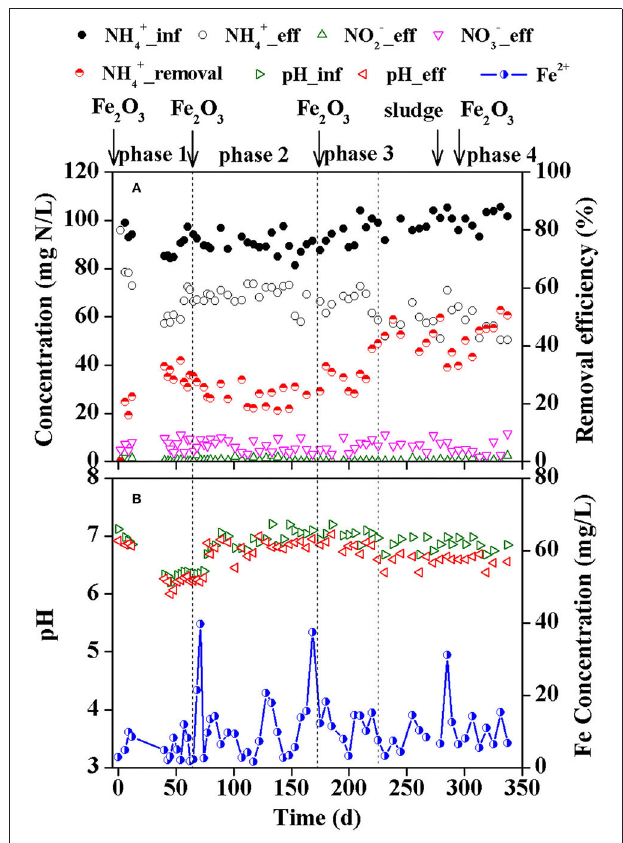
FIGURE 1 | Nitrogen concentration and ammonium removal efficiency (A) , and pH and effluent Fe(II) concentration (B) during the reactor